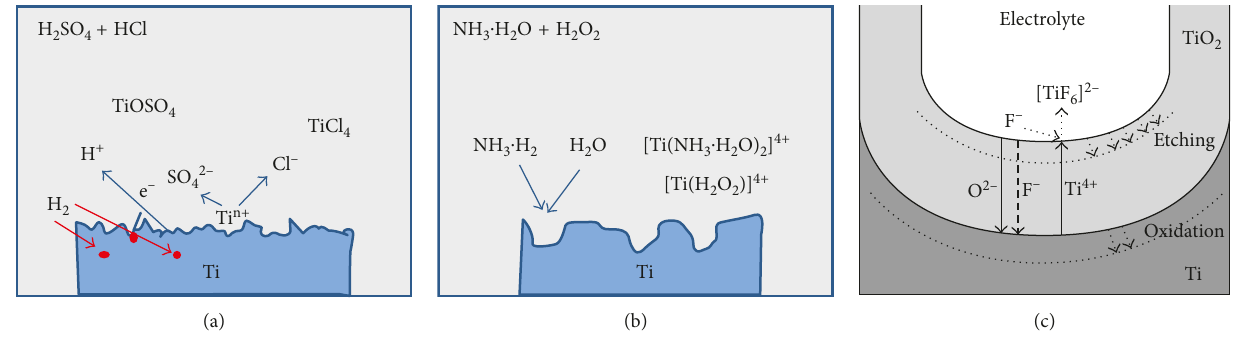
Figure 8: The corrosion mechanisms of H 2 SO 4 +HCl (a), NH 4 OH +H 2 O 2 (b), and anodization